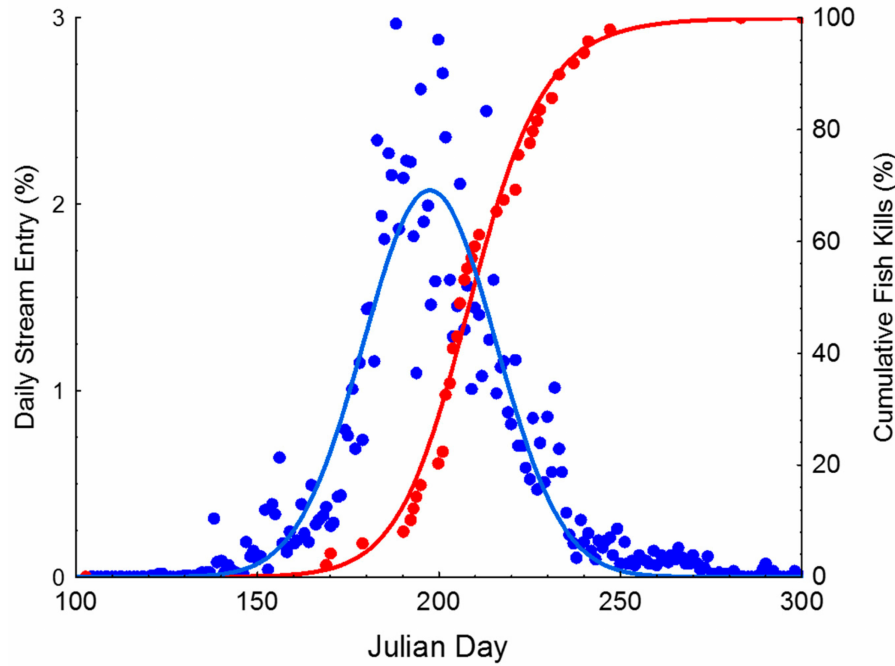
Figure 2. Timing of freshwater entry based upon 11 years of abundance data from the Montague River (blue) and the date of occurrence of pesticide fish kill events (red).